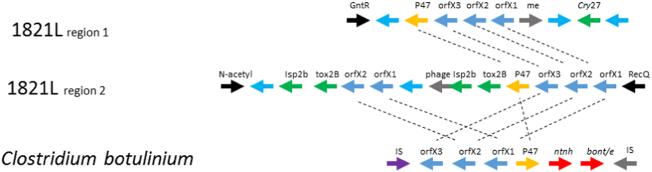
BoNT regions from 1821L and a representative region from Clostridium botulinium [35]. Blue arrows represent hypothetical proteins; N-acetyl-N-acetylmuramoyl-L-alanine amidase (EC 3.5.1.28); me – mobile element; Tox2B – Plx2b homology toxin type region with a Binary toxin B core. (For interpretation of the references to colour in this figure legend, the reader is referred to the web version of this article.)